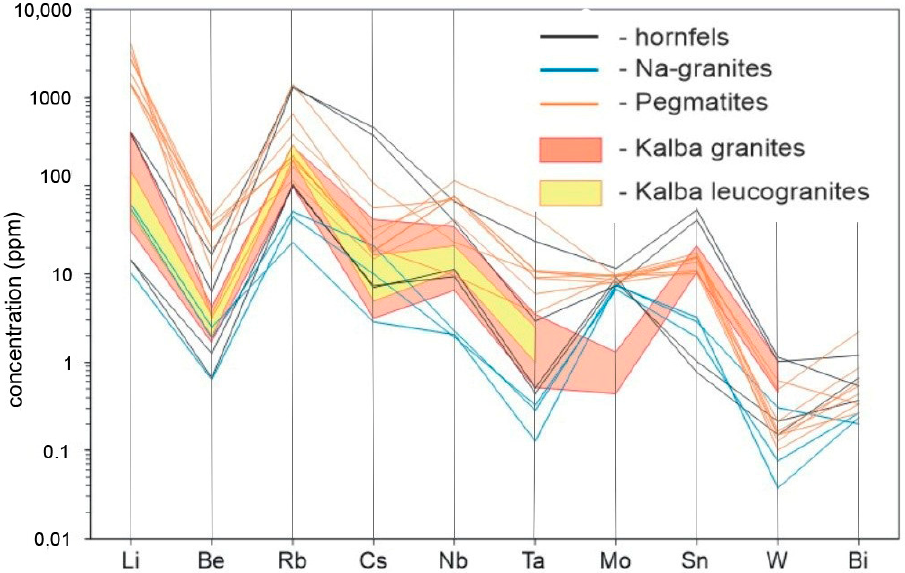
Figure 12. Distribution of rare metals (concentrations in ppm) in hornfelses, Na-granites, and pegmatites of the Tochka deposit in comparison with the Kalba granites and leucogranites. The composition of the Kalba granites and leucogranites are taken from [24,47]. The trace element (Ba, Th, HFSE, REE) behavior in the hornfelses is similar to the Kalba granites, whereas Na-granites and pegmatites show lower concentrations of these elements relative to the Kalba granites (Figure 13).